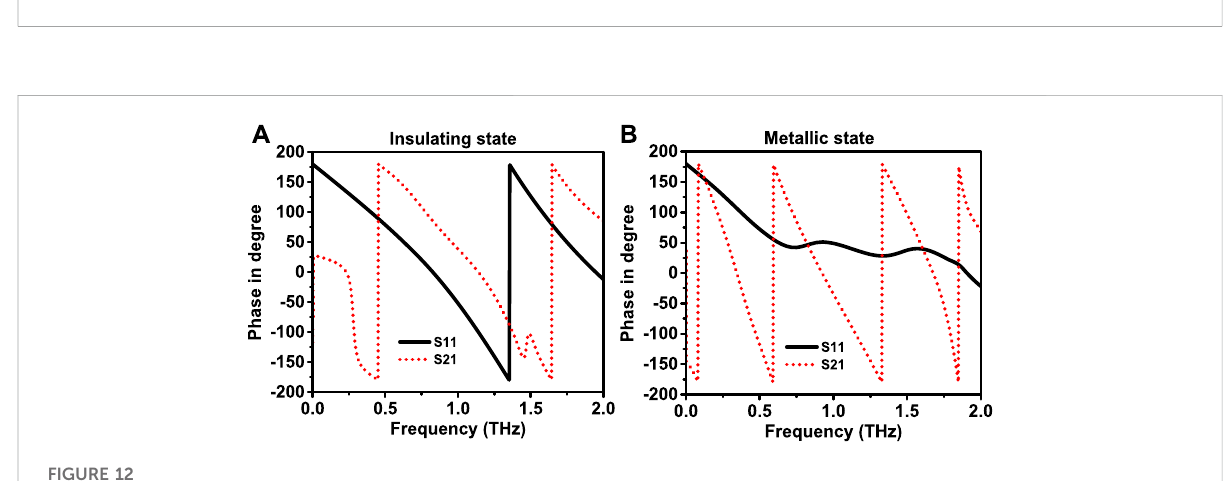
Figure 8. When the step size of change in the incident angle was 15 ° , no signi fi cant change was observed in the absorption characteristics, as shown in Figure 8A. Due to symmetric and